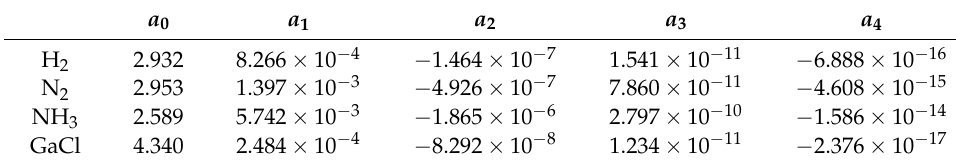
Table A1. Coefficients for C high p for each species.